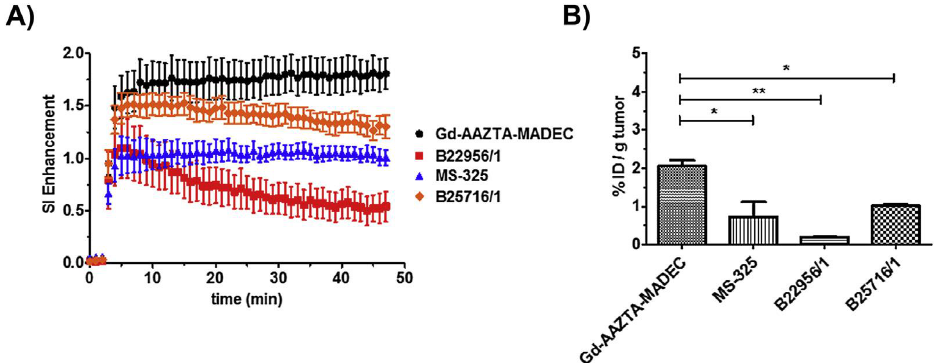
Figure 3. Kinetic study of MRI signal intensity enhancement in tumour of C57BL/6 mice transplanted subcutaneously with B16F10 melanoma cells, with intravenous injection (0.05 mmol Gd 3+ /kg) of Gd-AAZTA-MADEC (circles), Vasovist ® (MS-325) (triangles), Gd-B22956/1 (squares) and Gd-B25716/1 (diamonds) ( A ) and the Gd 3+ accumulation within tumour tissue at 60 min post-injection ( B ). Reprinted with permission from Ref. [26] (Copyright 2016 Elsevier).